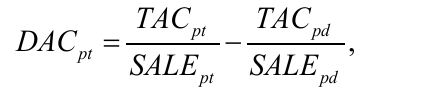
Table 1. Descriptive statistics of variables ( n = 63) Source: Authors’